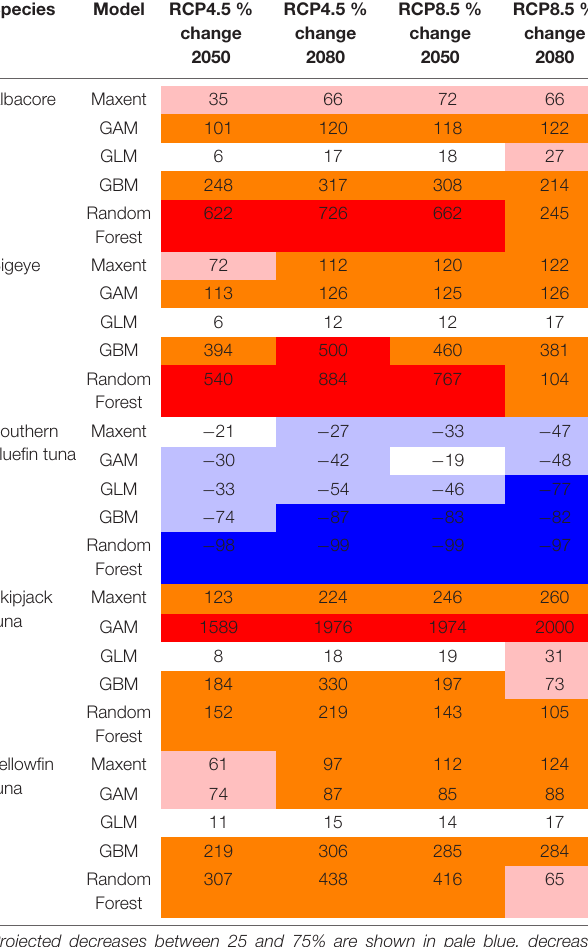
TABLE 2 | The minimum, median and maximum projected changes in habitat suitability in the St Helena EEZ for each species, for each model. Species Model RCP4.5 % change